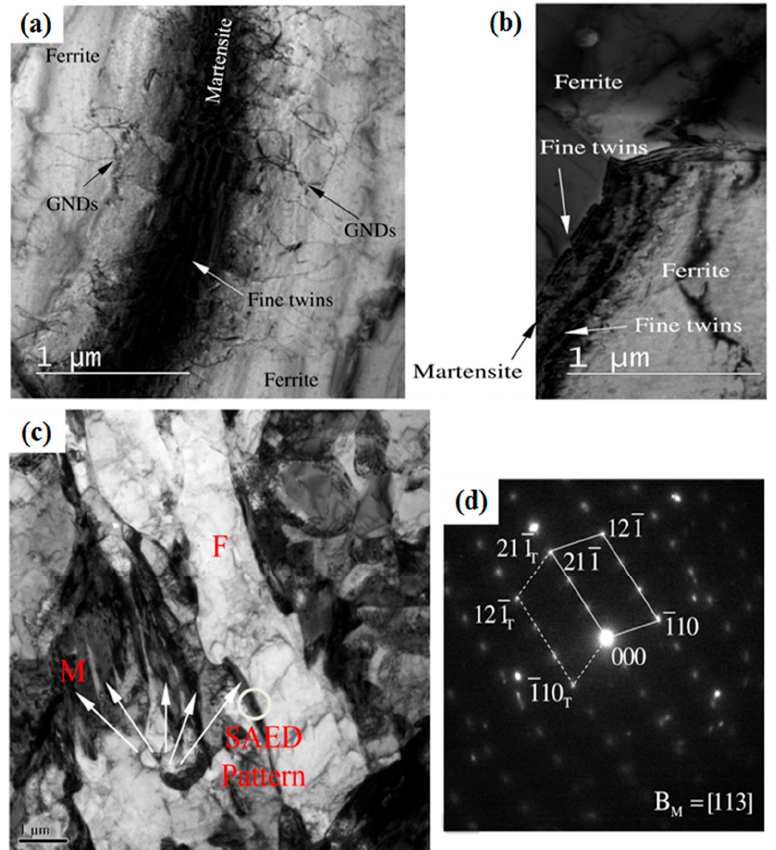
Figure 3. TEM micrographs of ( a , b ) DP steel [65], ( c ) DP steel (IQ steel), and ( d ) SAED pattern of ( c ) section. F = ferrite and M = martensite [66]. Reprinted with permission from refs. [65,66]. Copyright 2021 Elsevier.